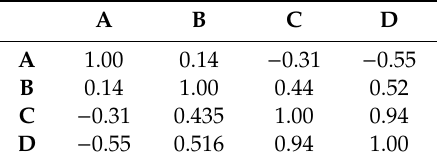
Table 3. Correlation between each trait–environment